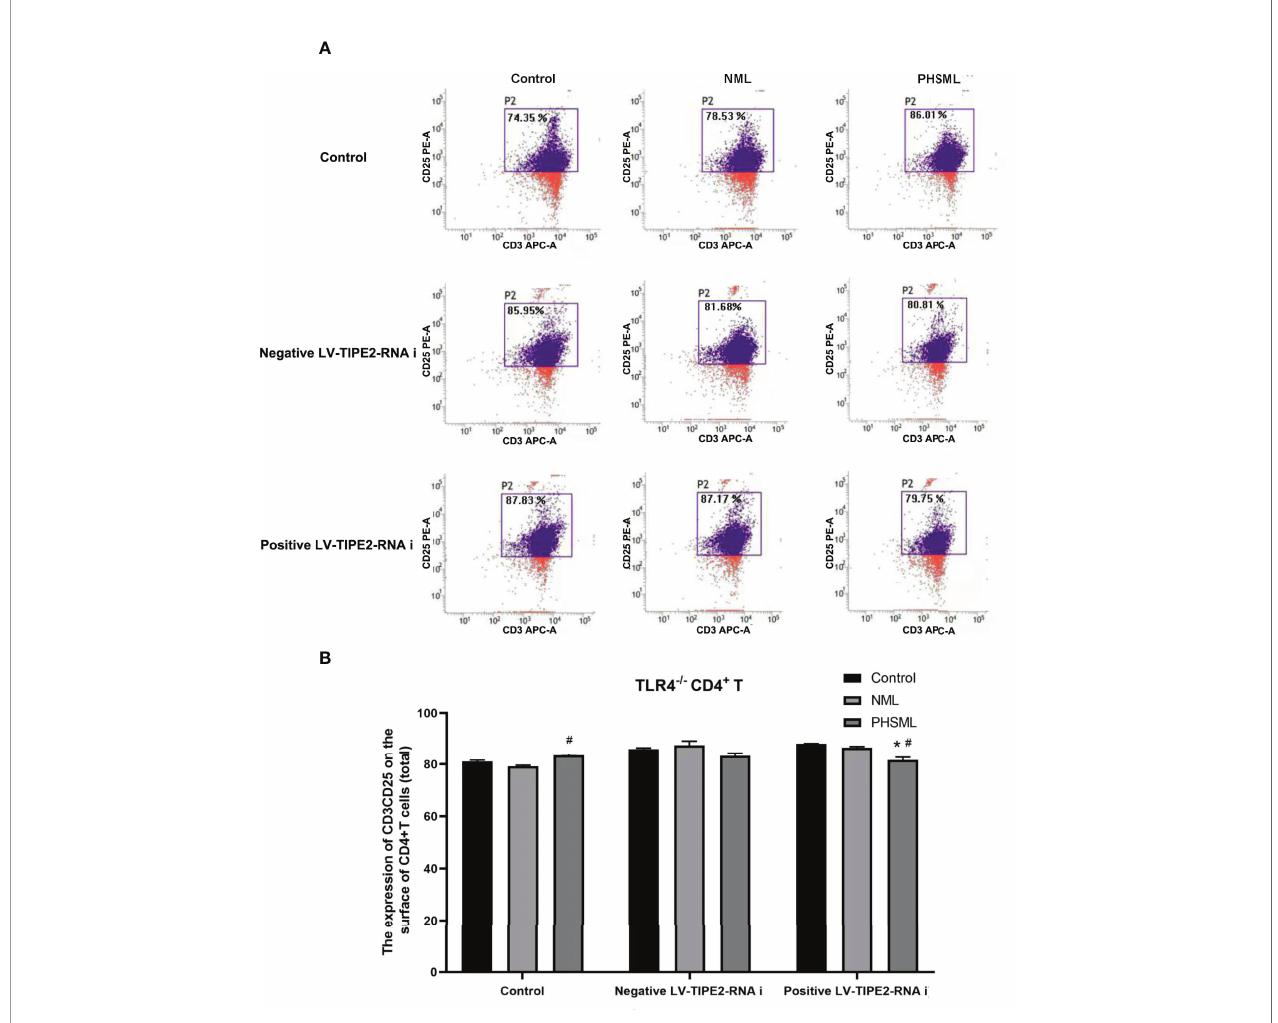
FIGURE 6 | The expression of CD25 on TLR4 -/- CD4 + T lymphocytes infected with TIPE2 shRNA following by the stimulation with PHSML detected by fl ow cytometry. (A) Representative images. (B) The percentage of CD4 + T cells expressing CD25 is expressed as the mean ± SE and is shown in a bar graph. Data are derived from three independent experiments. *P < 0.05 vs control treated control group, #P < 0.05 vs PHSML treated control